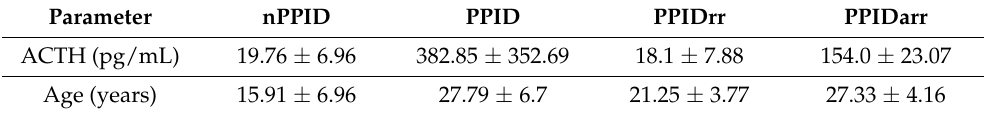
Table 1. Age and ACTH concentrations of the tested horses (mean ± standard deviation).